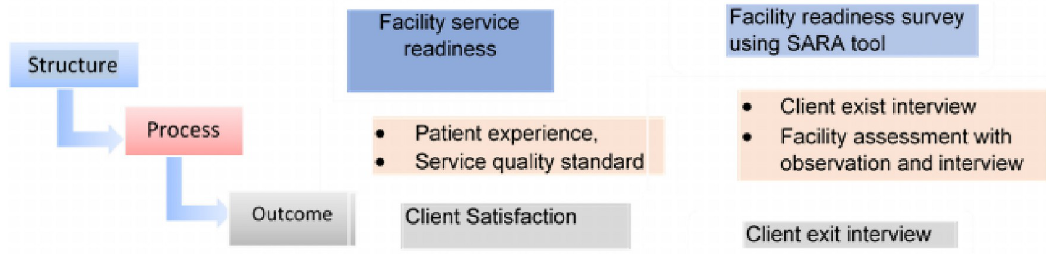
Fig 1. Quality of care measurement domains and data